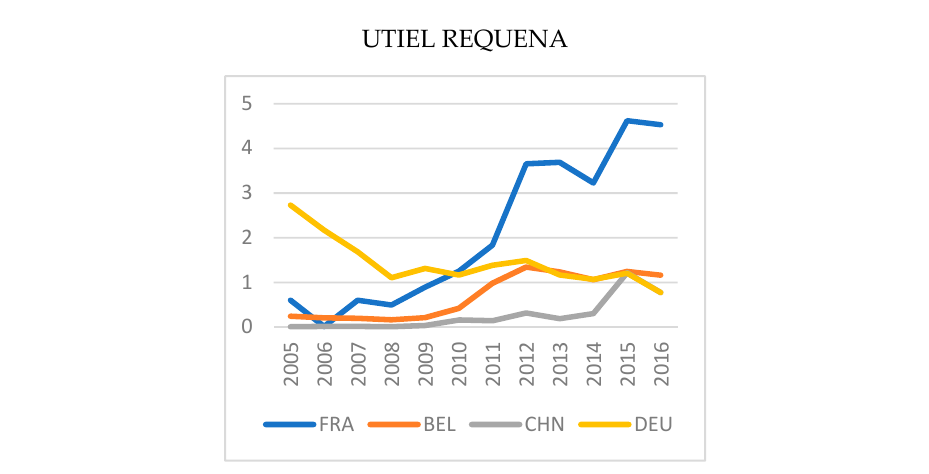
Figure 2. Evolution of CO 2 emissions generated by Spanish wine exports from each DO in relation to the most significant importing countries.